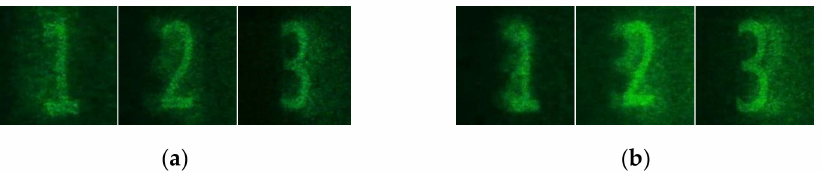
Figure 12. Experimental results of reconstruction with same depth but different view ( a ) with phase-locked algorithm and ( b ) without phase-locked